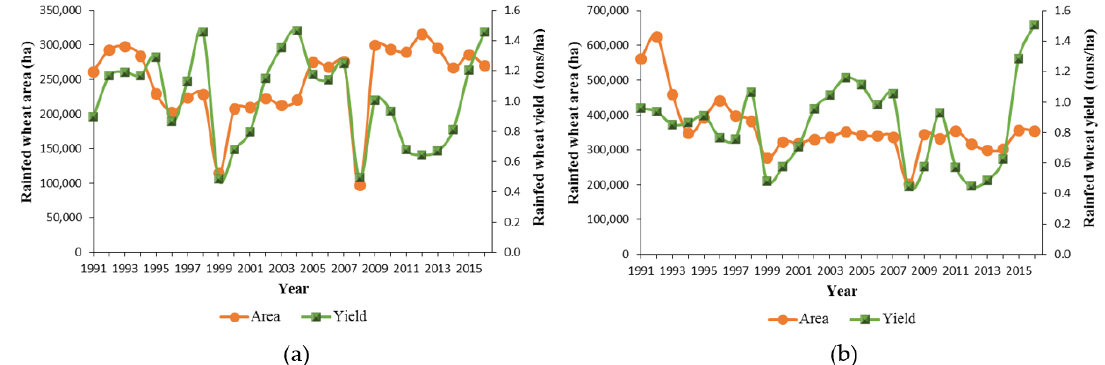
Figure 2. Rain-fed wheat yield in tons per hectare and per area in West Azerbaijan and East Azerbaijan Provinces. ( a ) West Azerbaijan Province. ( b ) East Azerbaijan Province.